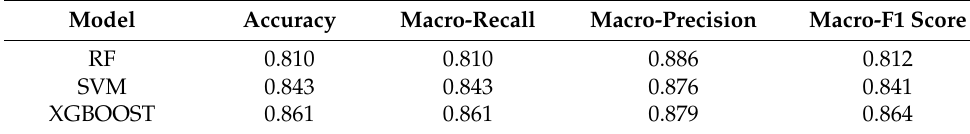
Table 2. Performance parameters of machine learning algorithms.